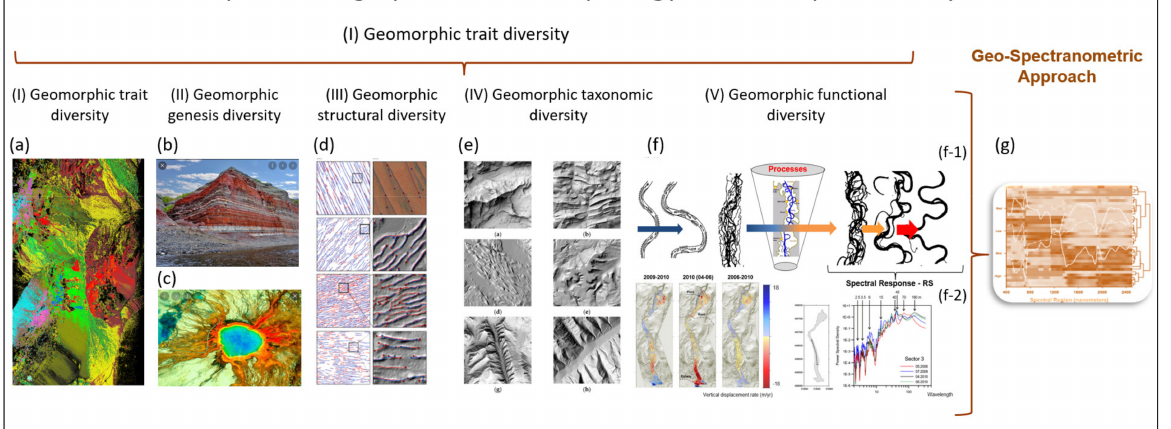
Figure 10. All five characteristics of geomorphodiversity can be recorded using RS technologies. The individual characteristics of geomorphodiversity are illustrated by means of examples, which are: (I) geomorphic trait diversity, ( a ) AVIRIS hyperspectral RS data was used to classify the mineral distribution and the geomorphic traits in the Cuprite area, Nevada (from Clark et al. [96]); (II)